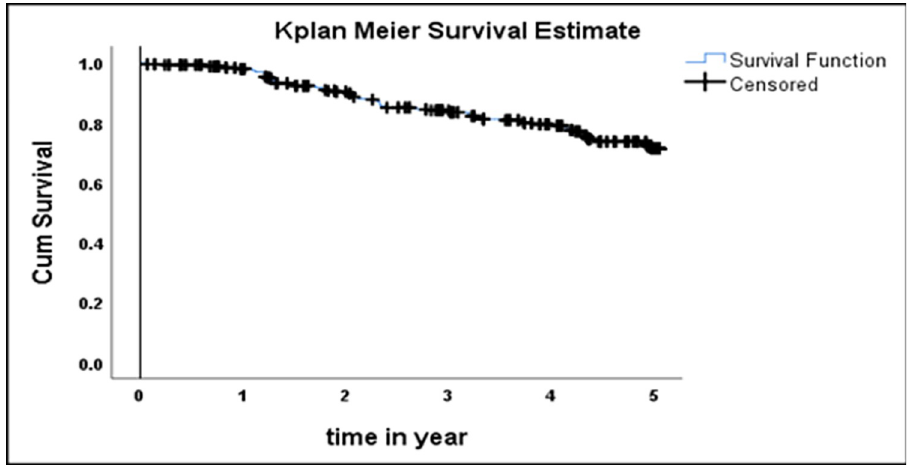
Fig 1. Kaplan-Meier curve of anemia-free survival probability among HIV positive adults on ART at Debre Tabor Hospital, January 1, 2015 to December 30, 2019.